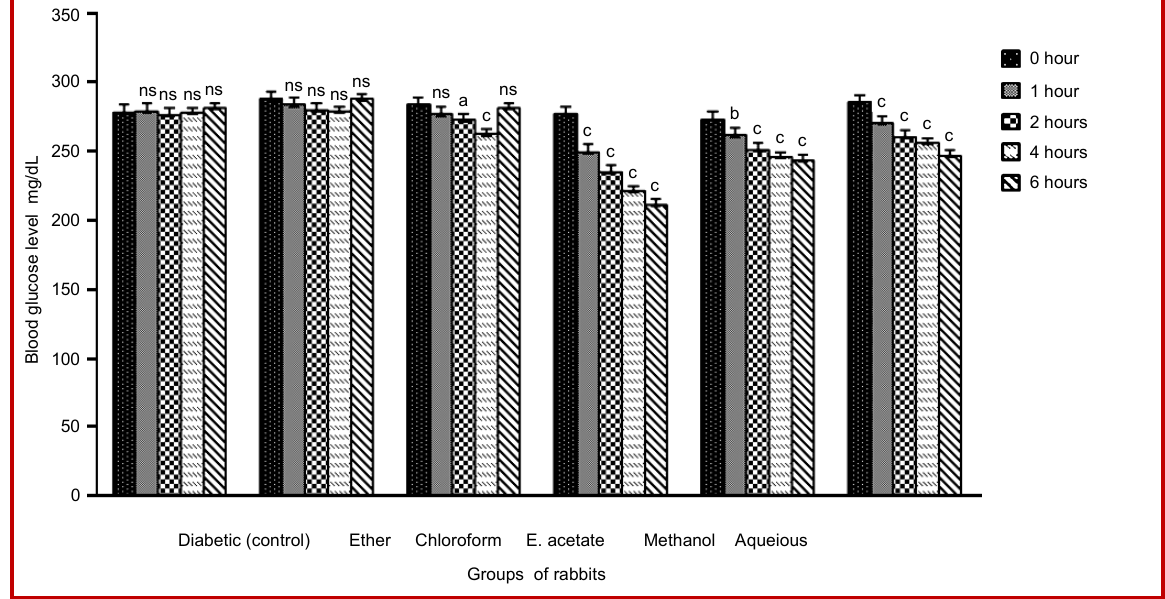
Figure 3: Hypoglycemic effect of different extracts of Teucrium stocksianum in diabetic rabbits. (n = 6) where, ns = Non significant change; a p<0.05; b p<0.01; c p<0.001 as compared to 0 hour